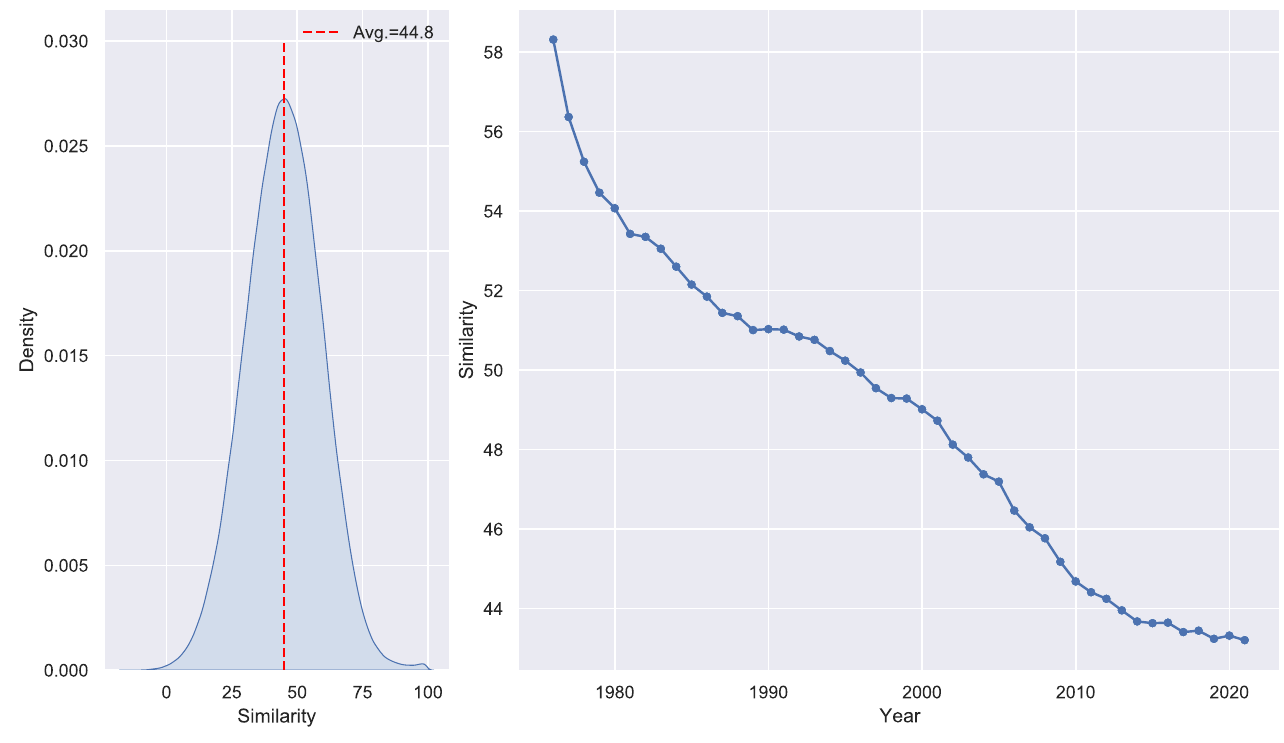
Fig 2. Citation similarity. Left : similarity distribution. Right : average citation similarity per year.